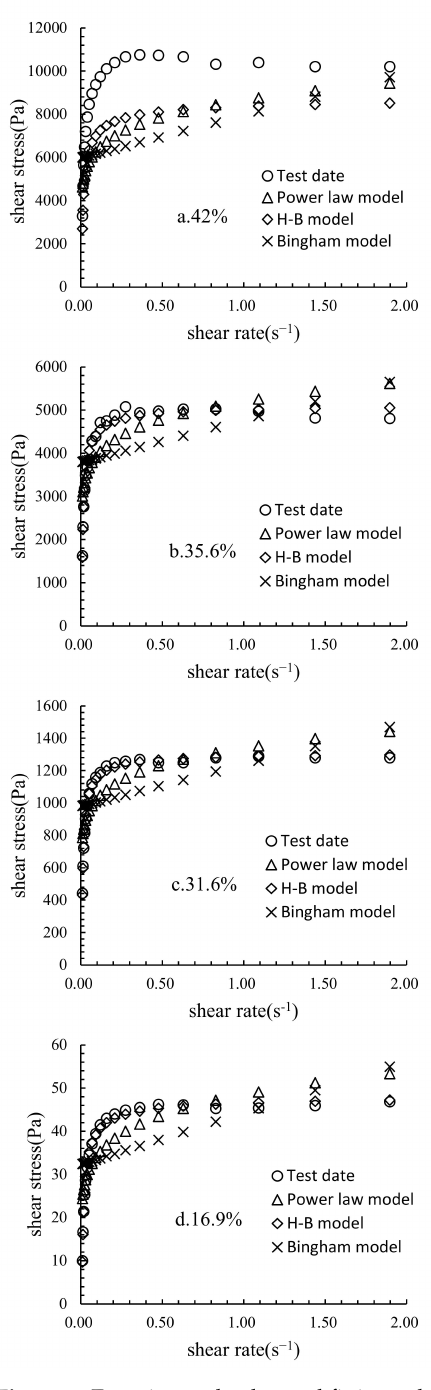
Figure 3. Experimental value and fitting value of the relationship between shear stress and shear rate of Chengdu clay mud with different water